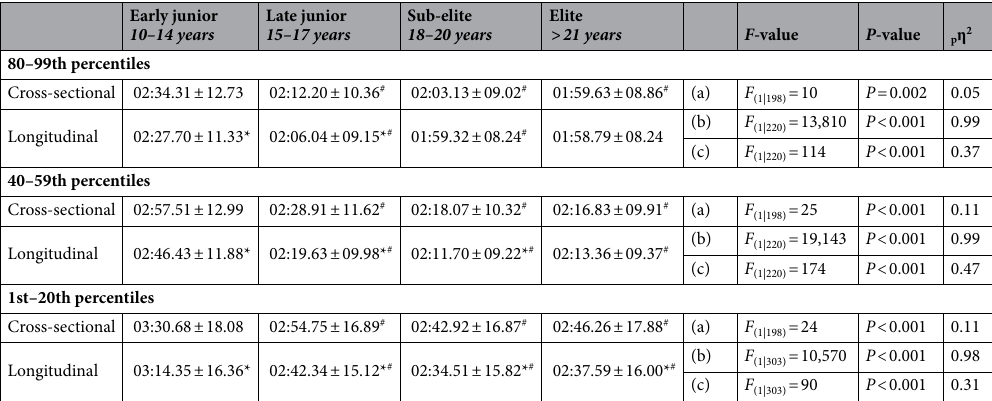
Table 1. Comparison of percentiles based on cross-sectional vs. longitudinal analysis of male swimmers. Analysis of variance (ANOVA) with repeated measure and one between subject factor was used to compare upper (80–99th), medium (40–59th), and lower percentiles (1st–20th) based on mean [mm:ss.00] ± standard deviation [ss.00] across the 200 m events of all swimming strokes. (a) Main effect: type of analysis (cross- sectional vs. longitudinal). (b) Main effect: age category (early junior−late junior–sub-elite–elite). (c) Interaction effect: type of analysis × age group. Post-hoc comparison. *Significant difference to cross-sectional analysis. # Significant difference to previous age category.